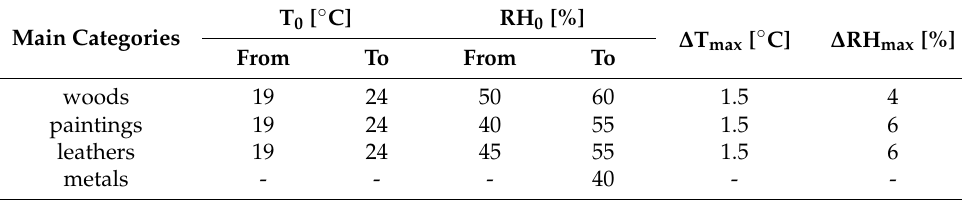
Table 2. T and RH reference values for the conservation of the main categories of materials